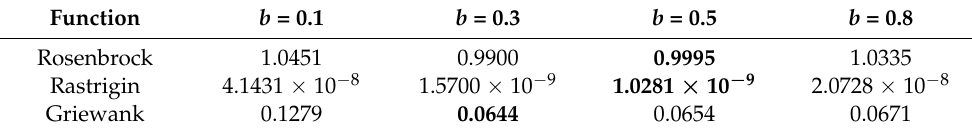
Table 3. Mean optimal function value of three criterion functions with different values of parameter b